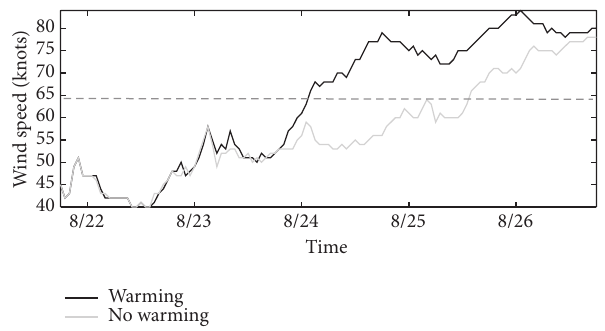
Figure 3: WRF simulated intensities of Tembin during the passage of warming (nonwarming) patch. Gray dashed line denotes the intensity of Category 1 in Saffir-Simpson hurricane wind